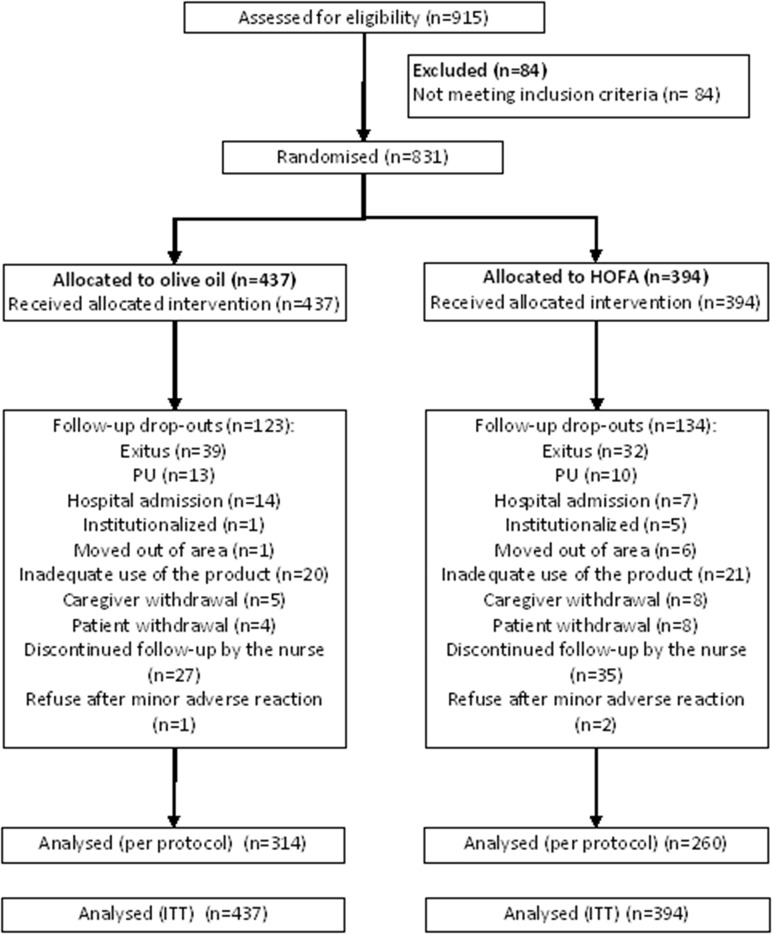
Patients Flow-chart.